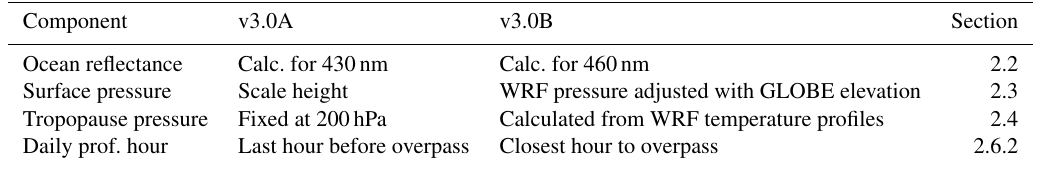
Table 2. Summary of differences in methods between v3.0A and v3.0B.